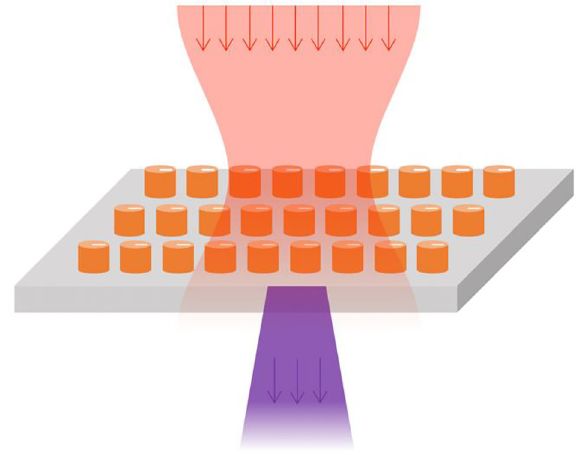
Figure 1: Schematic illustration of the second-harmonic genera- tions (SHG) enhanced by the quasi-bound state in the continuum (QBIC) mode supported by slotted AlGaAs disk array. The red beam represents the incident wave at QBIC resonance while the outgoing purple beam is the generated second harmonic (SH)